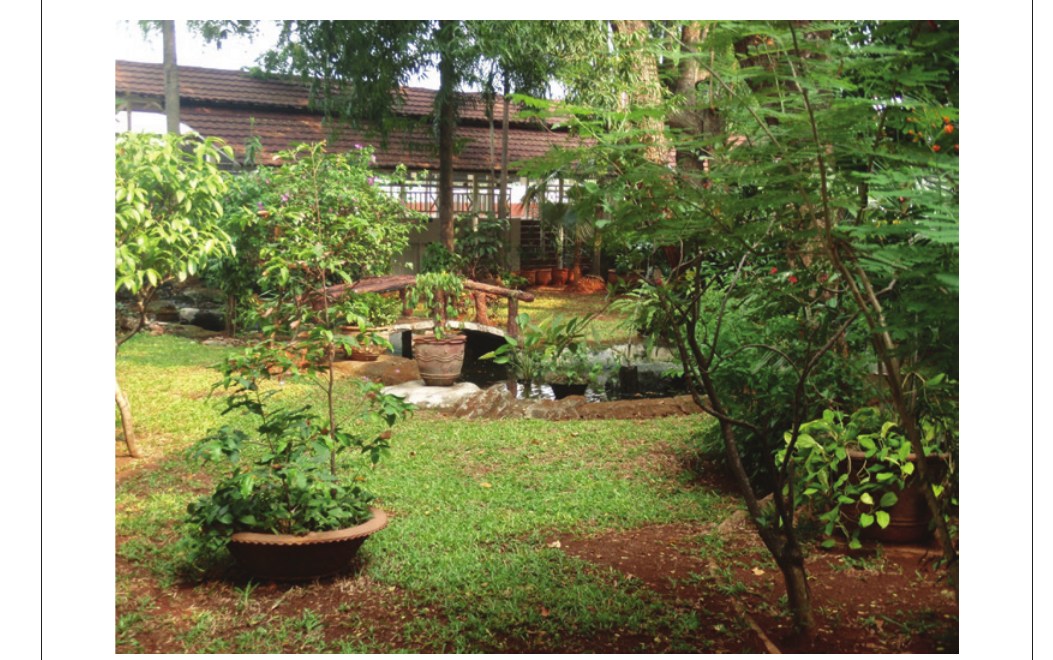
figure 2: the indigenous garden (Source: elisabeth barratt Hacking,